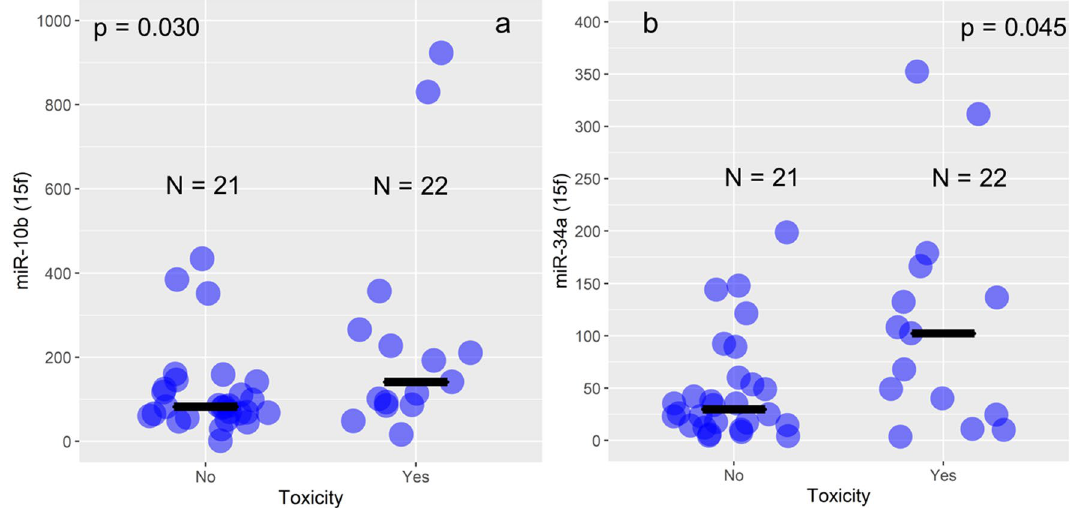
Figure 2. Comparison between patients with and without side effects at the 15th fraction of RT. Violet dots represent each patient, while the black line represents the median value of miR-10b ( a ) and miR-34a ( b ) expression values ( RQ relative quantity units) at each analyzed group-with and without side effects at the 15th